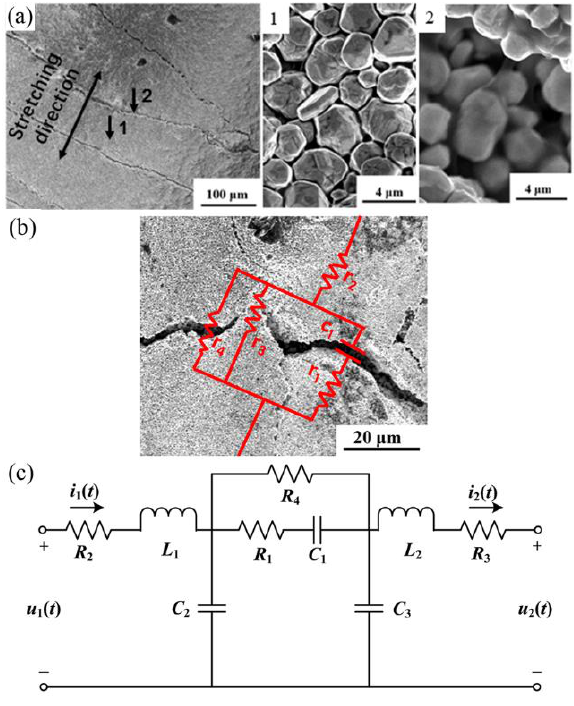
Figure 3. ( a ) Scanning electron microscope (SEM) images of the microstrip with microcracks. 1 and 2 are SEM images of the complete surface and the bottom of the microcrack, respectively. ( b ) The equivalent circuit of a section of the conductor. ( c ) The equivalent circuit model of the microstrip with